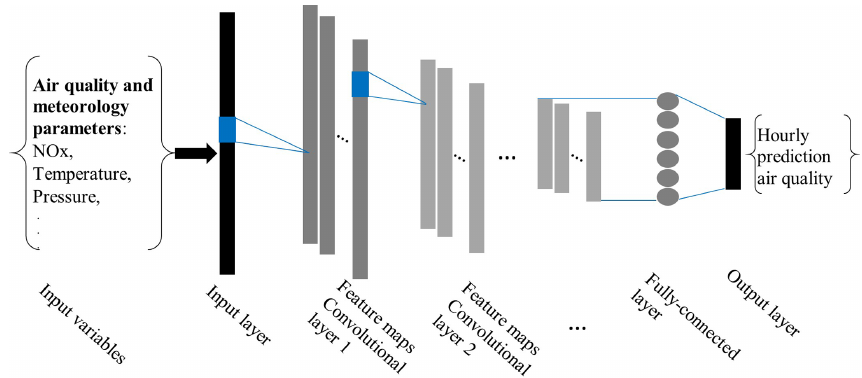
Figure 1. Schematic of the deep CNN model in our